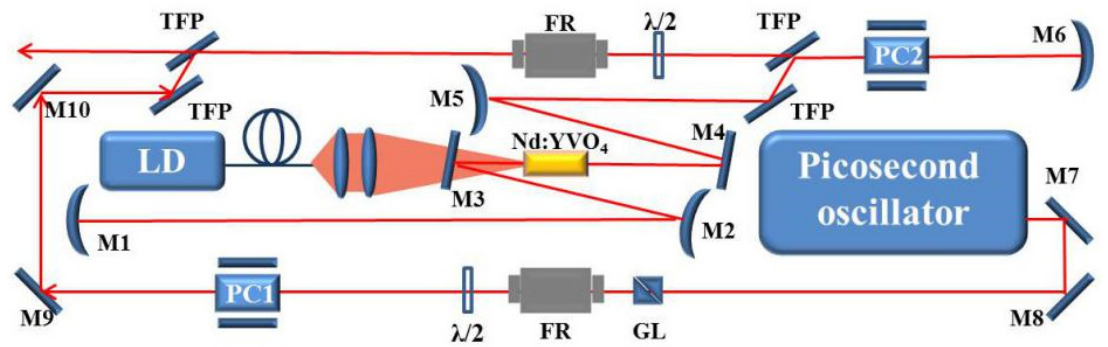
Figure 4. The scheme of the regenerative amplifier operating at a repetition rate of 1 kHz. M1, M6: Concave mirrors, R = 900 mm; M2, M5: Convex mirrors, R = − 1000 mm; M3, M4, M7–M10: Plane high-reflection mirrors; PC: Pockels cell; TFP: Thin-film polarizer; FR: Faraday rotator; GL: Glan